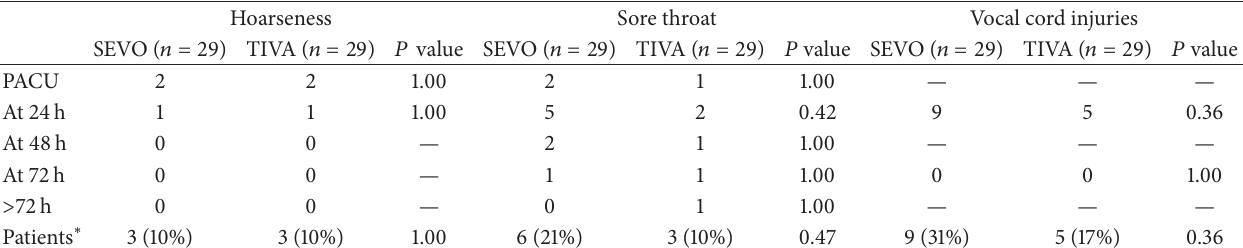
Table 4: Incidence of hoarseness, sore throat, and vocal cord injuries.